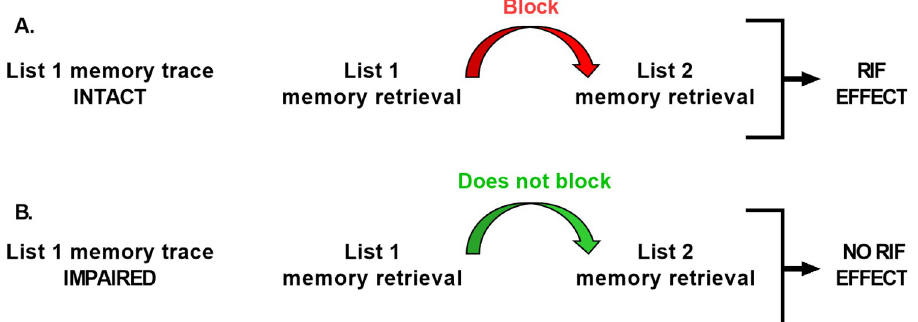
Fig 2. Method to test List 1 memory trace impairment. According to the Retrieval- Induced Forgetting effect (RIF), retrieval of one memory can temporarily block subsequent retrieval of other related memories. (A) RIF effect is only observed when the memory trace that is recalled first is intact (B) RIF effect is not observed when the first recalled memory trace is impaired. Anderson et al., 1994; MacLeod & Macrae, 2001, Forcato et al., 2007.